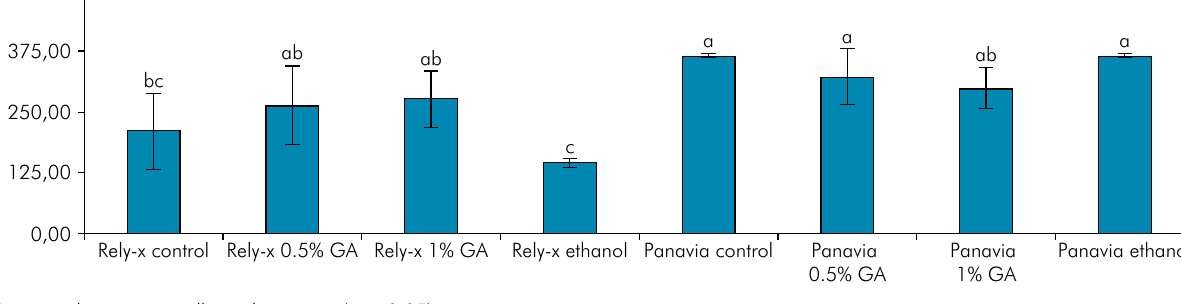
Figure 1. Setting